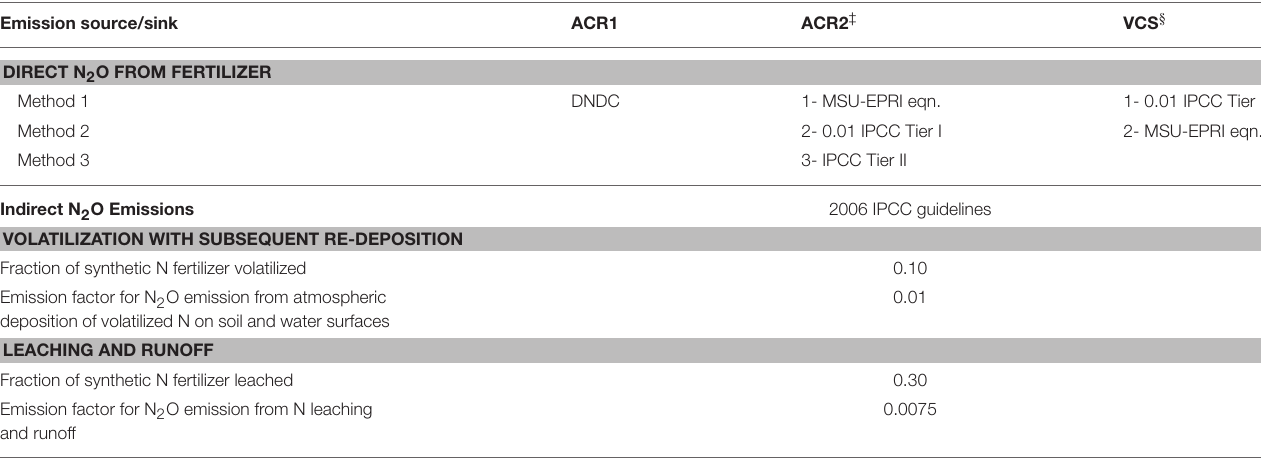
TABLE 5 | Comparison of approaches for calculating direct † and indirect N 2 O